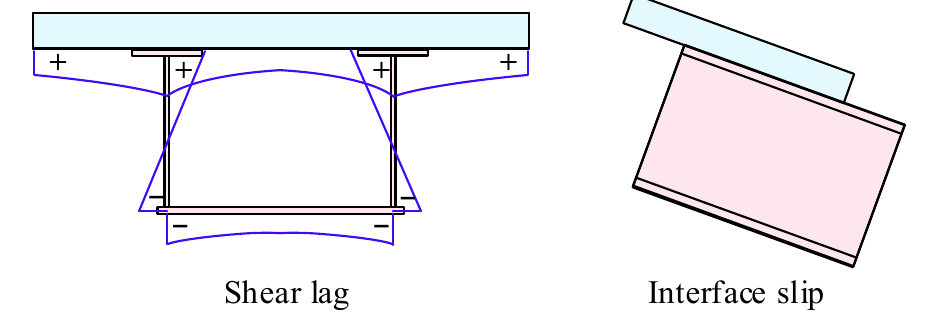
Figure 1. Shear lag and interface slip of a steel–concrete composite box beam.